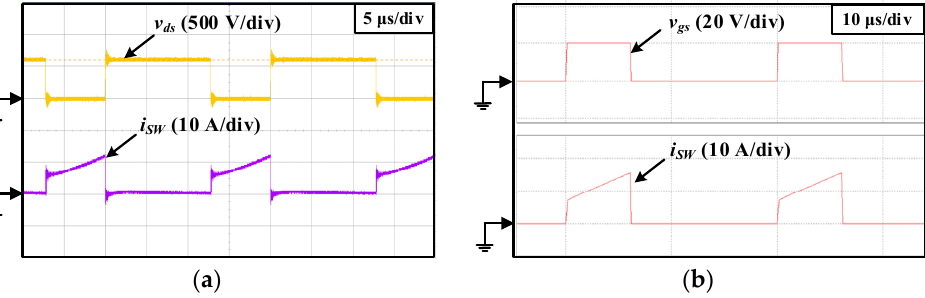
Figure 14. The waveforms: ( a ) measured switch voltage and current, ( b ) simulated control signal and switch current.